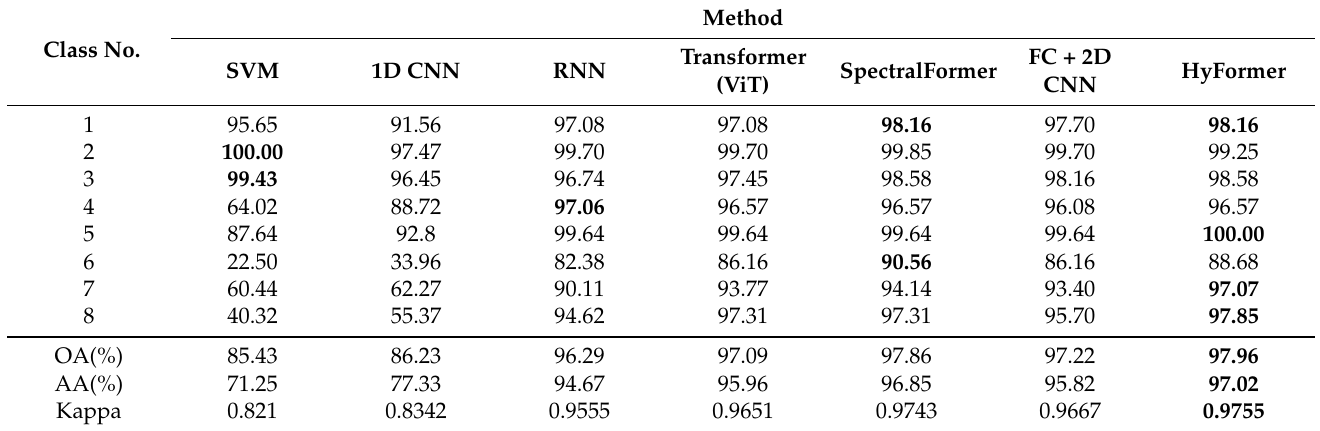
Table 8. Comparison of the classification results of different classification methods on the dataset after adding red edge bands.